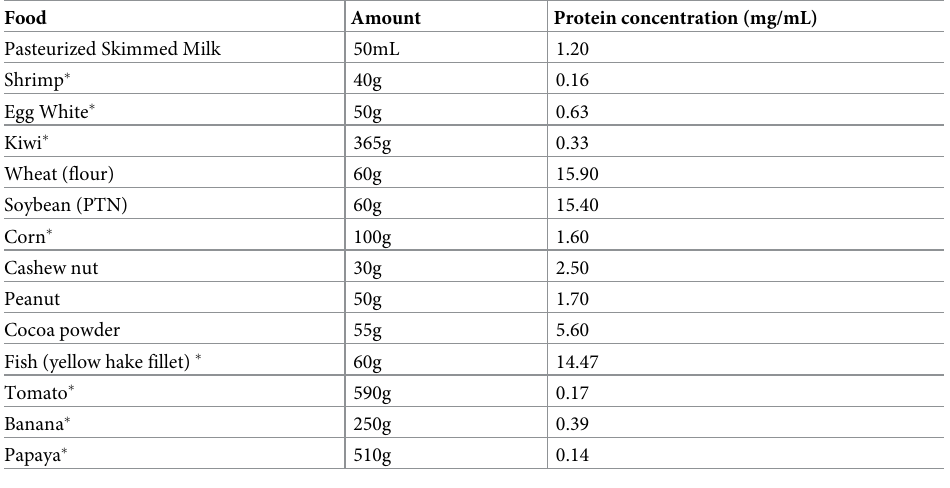
Table 1. Quantification of total proteins by the method of Bradford (1976). Food Amount Protein concentration